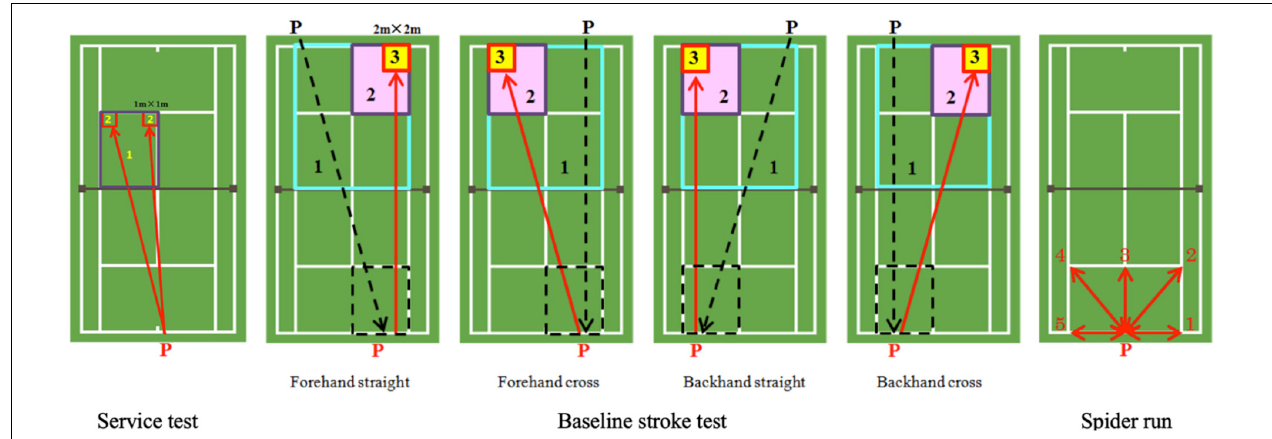
FIGURE 1 | Athletic performance test. Black P is player who strike ball to participant. Red P is participant who strike ball coming from opposite